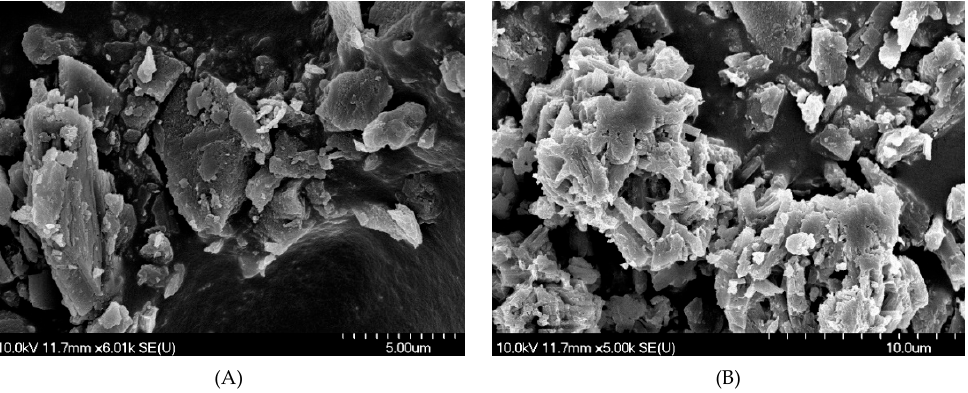
Figure 8. SEM images of the precipitated Mg(OH) 2 ( A ): washed sample (does not contain gypsum according to XRD) and ( B ): unwashed sample (some gypsum present according to XRD).